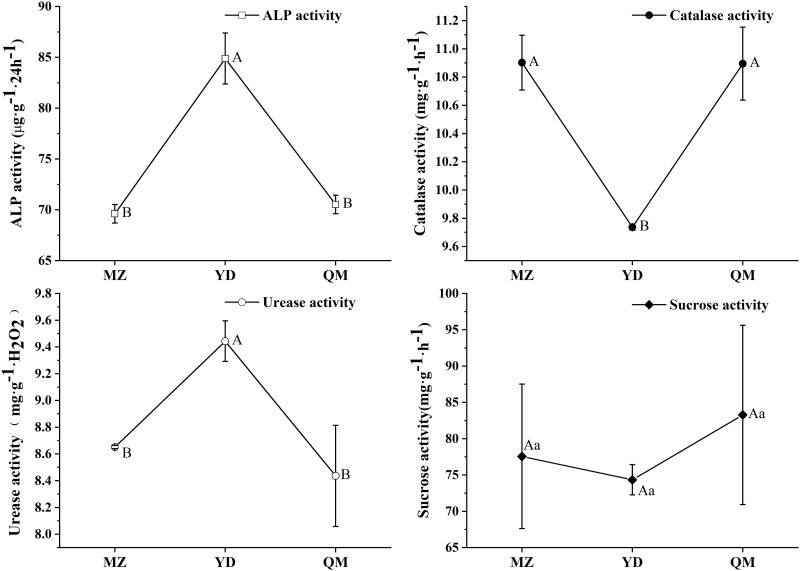
Soil alkaline phosphatase (ALP) activity (A), soil urease activity (B), soil catalase activity (C), and soil sucrose activity (D) of three soils.MZ = continuous cropping proso millet for 5 years, YD = continuous cropping common bean for 5 years, QM = continuous cropping common buckwheat for 5 years. Bars within sampling dates topped by the same letter are not significantly different according to Duncan's test at P<0.05.